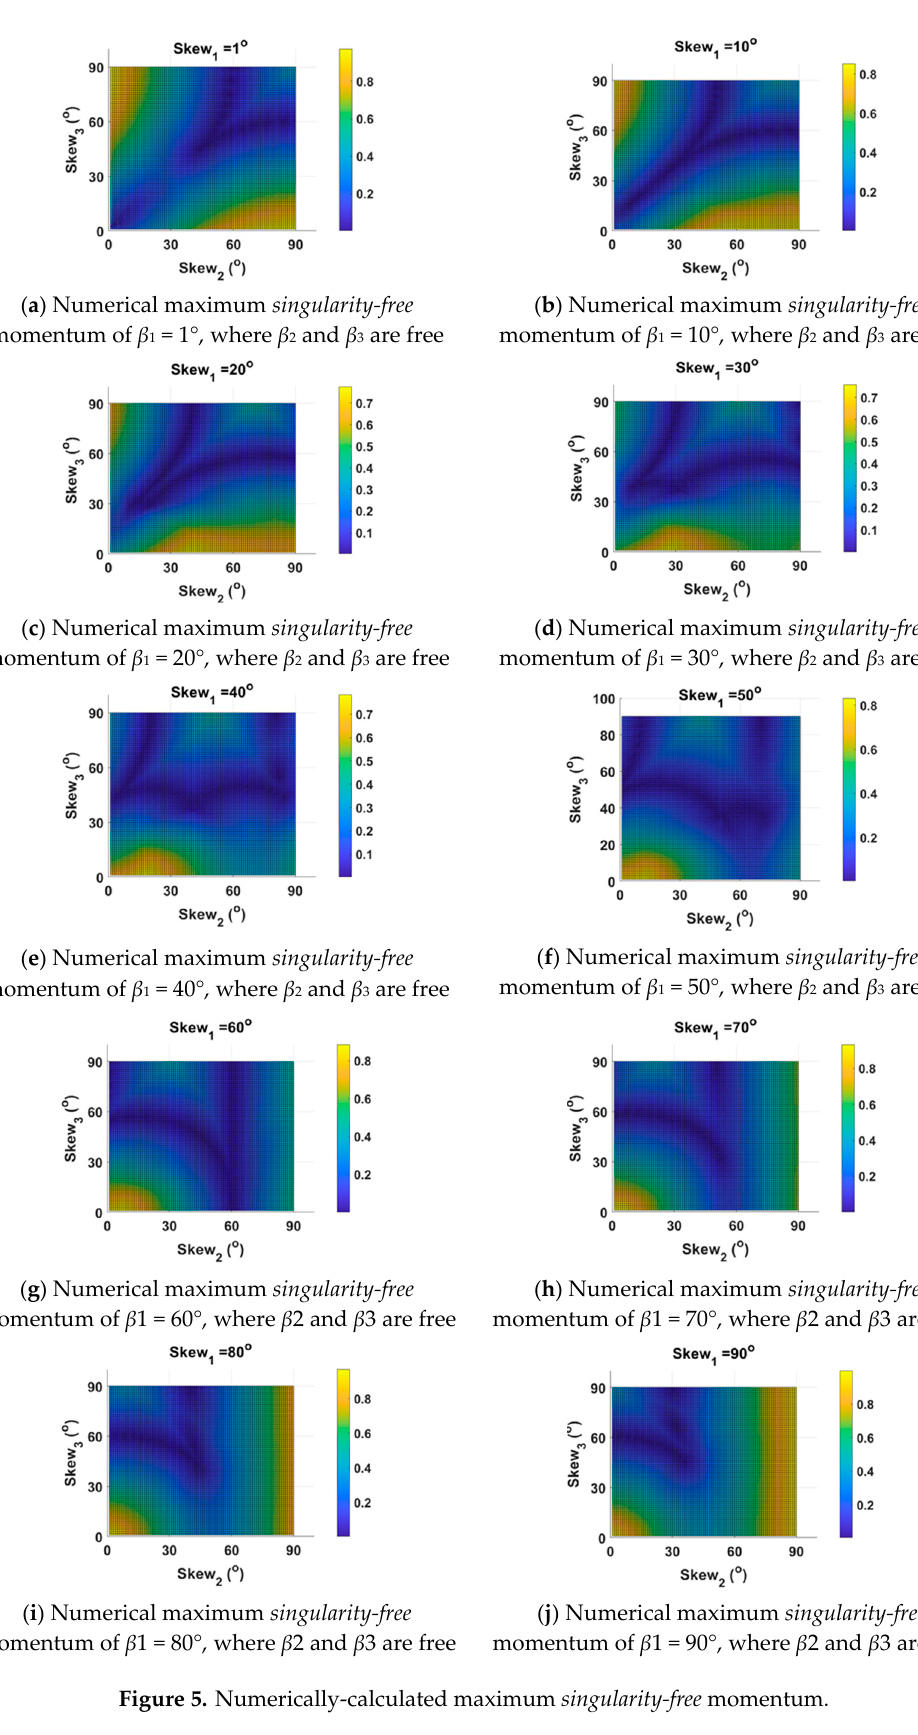
Figure 5. Numerically-calculated maximum singularity-free momentum.